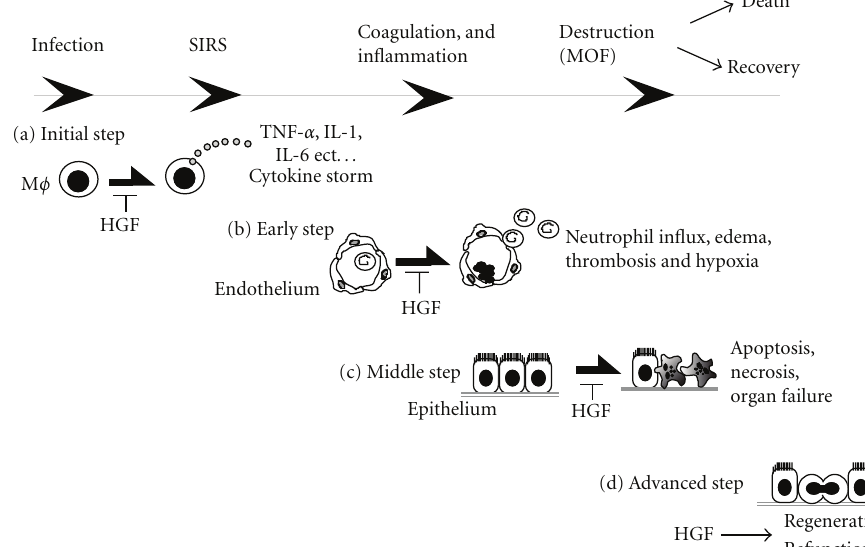
Figure 4: Step-by-step therapy using HGF in a chronology of septic phases including infection, SIRS, coagulation, and MOF. HGF inhibits the development of sepsis-induced MOF through di ff erent ways at di ff erent phases. (a) In an initial step, HGF targets endotoxin-primed macrophages and inhibits cytokine storm via indirect (i.e., HO-1 recruitment) and direct (i.e., GSK3 β inactivation) pathways [29, 46]; (b) in an early step (i.e., post-cytokine storm), HGF protects endothelial cells from cytokine-induced inflammatory events, such as ICAM-1 and E-selectin overexpressions [32–34], and HGF also prevents DIC via the preservation of thrombomodulin on endothelial cells [44, 45]; (c) in a middle step (i.e., after coagulation), HGF protects resident functional cells from hypoxia or cytokines via early induction of Bcl-xL or Bcl-2 [40]; finally (d) in an advanced stage (i.e., after injury), HGF enhances tissue repair via enhancing mitogenesis and morphogenesis of surviving epithelial cells [10,